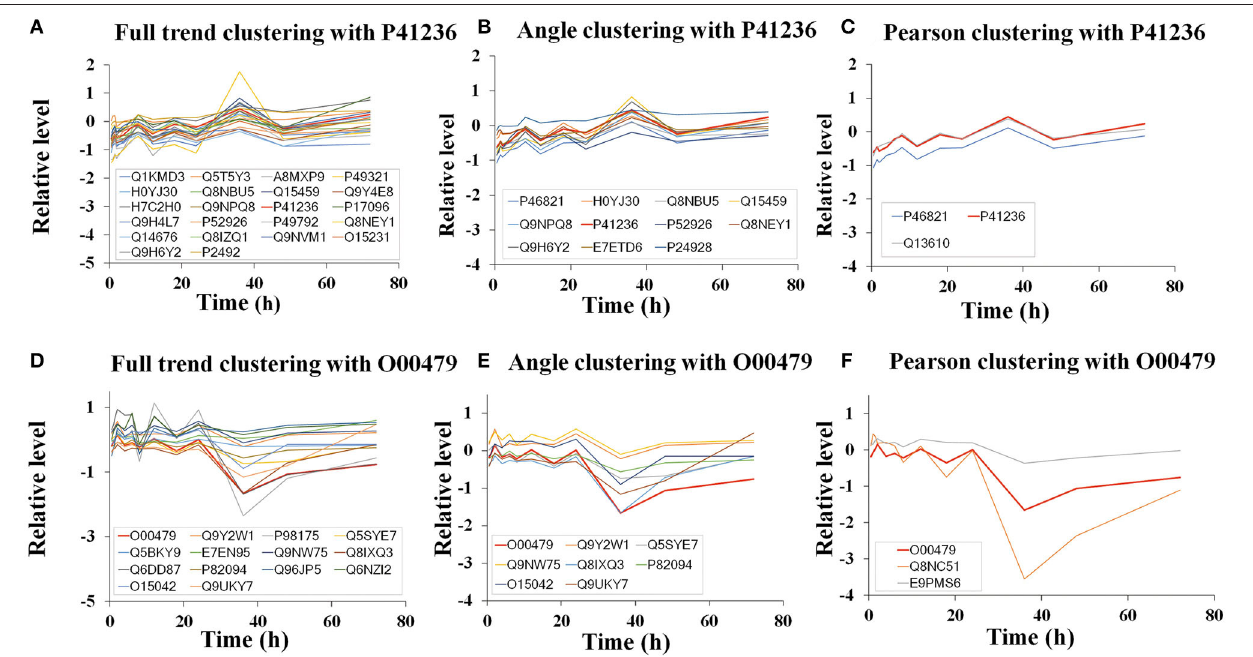
FIGURE 4 | The representative results of clustering using different clustering methods. (A–C) The clusters obtained by different clustering methods, including full trend clustering (A) , angle clustering (B) , and Pearson clustering (C) . The trends of relative expression levels of the proteins in these clusters were consistent with P41236. (D–F) The clusters obtained by different clustering methods, including full trend clustering (D) , angle clustering (E) , and Pearson clustering (F) . The trends of the relative expression levels of the proteins in these clusters were consistent with O00479.